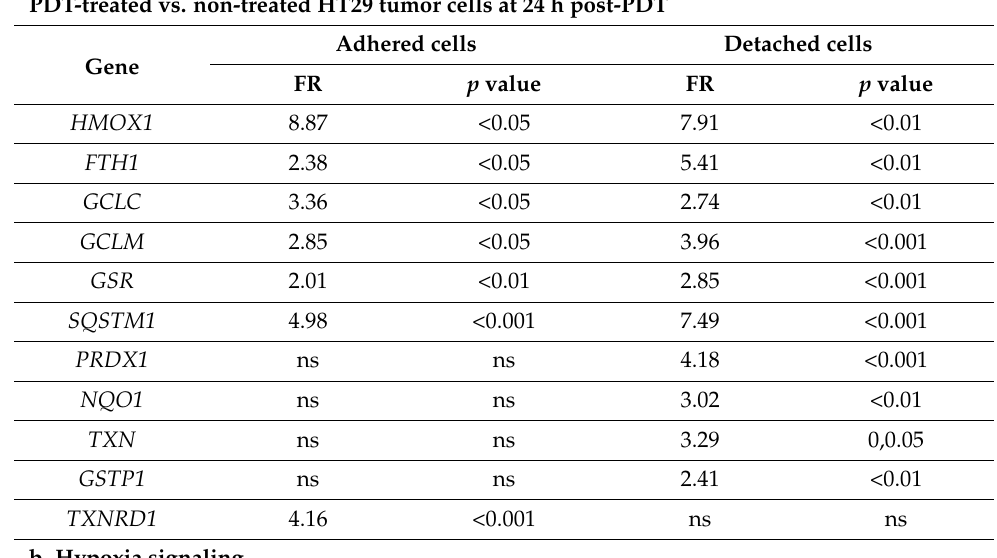
Table 2. Genes with statistically significant expression changes (1.5 < FR < − 1.5, p < 0.05) in PDT- treated cells (10 J/cm 2 , 50 mW/cm 2 ), either adhered or detached, as compared to untreated controls. Gene expression levels were assessed at 24 h post-PDT. Genes were classified according to the type of stress in which they are involved. Some genes are common to several types of stress. ns = not